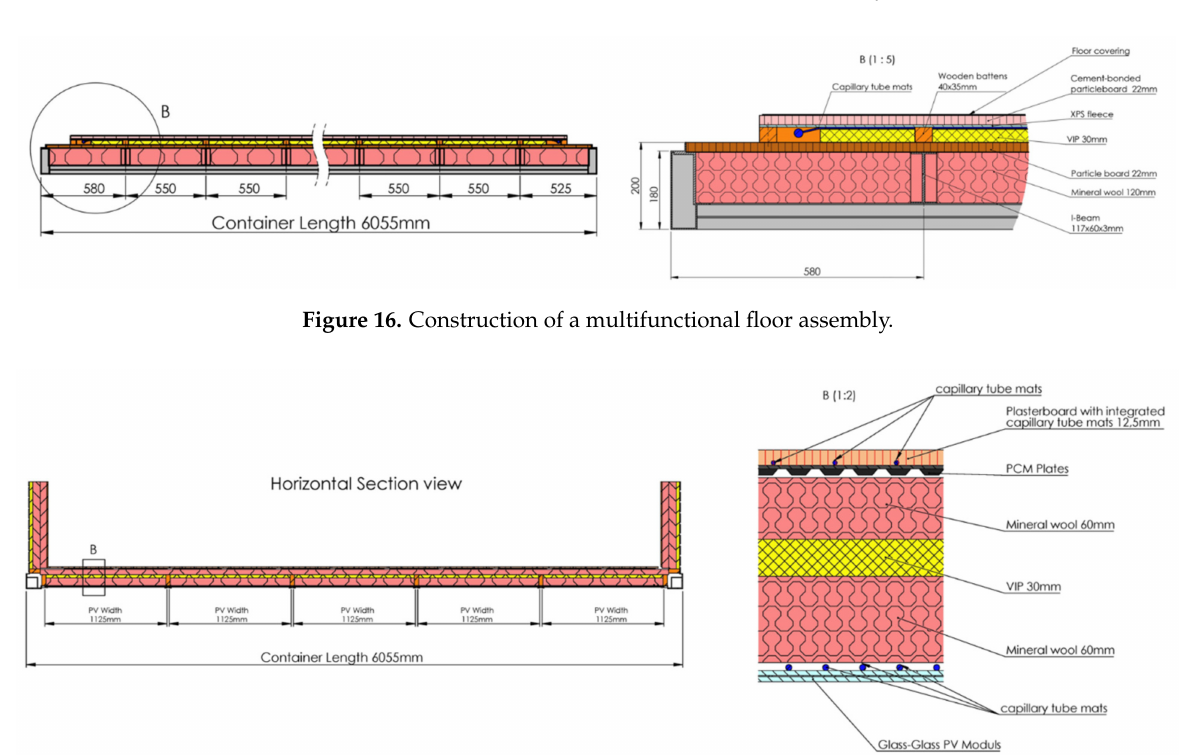
Figure 15. Construction of a multifunctional roof assembly.